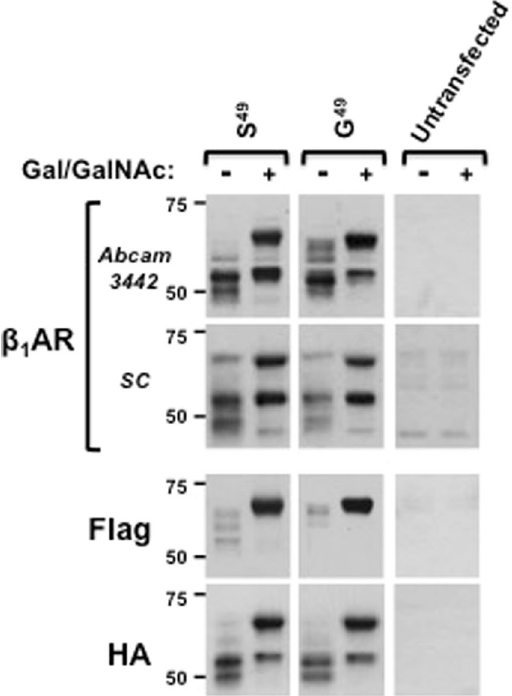
Figure 2. The S49G polymorphic variant does not grossly influence β 1 AR glycosylation profiles in ldlD cells. Lysates from ldlD cells transiently transfected with plasmids that drive expression of either S 49 - or G 49 - β 1 ARs and cultured without or with Gal (20 μ M) and GalNAc (200 μ M) were subjected to immunoblot analysis with two different anti- β 1 AR antibodies as well as antibodies to Flag and HA epitope tags at the N- and C-termini, respectively. The figure shows that the Abcam anti- β 1 AR antibody (ab3442, raised against residues 394–408 in human β 1 ARs) and the Santa Cruz anti- β 1 AR antibody (raised against some undefined C-terminal epitope) both detect the heterologously overexpressed β 1 AR. However, immunoblots with the Santa Cruz anti- β 1 AR antibody also contain some non-specific immunoreactivity. In particular, a ~69-kDa non-specific band that co- migrates with the full-length, fully glycosylated β 1 AR can become rather problematic at low levels of